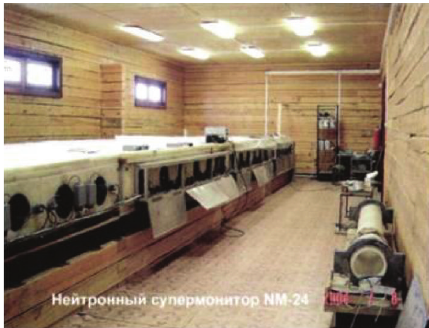
Figure 8: Neutron monitor in